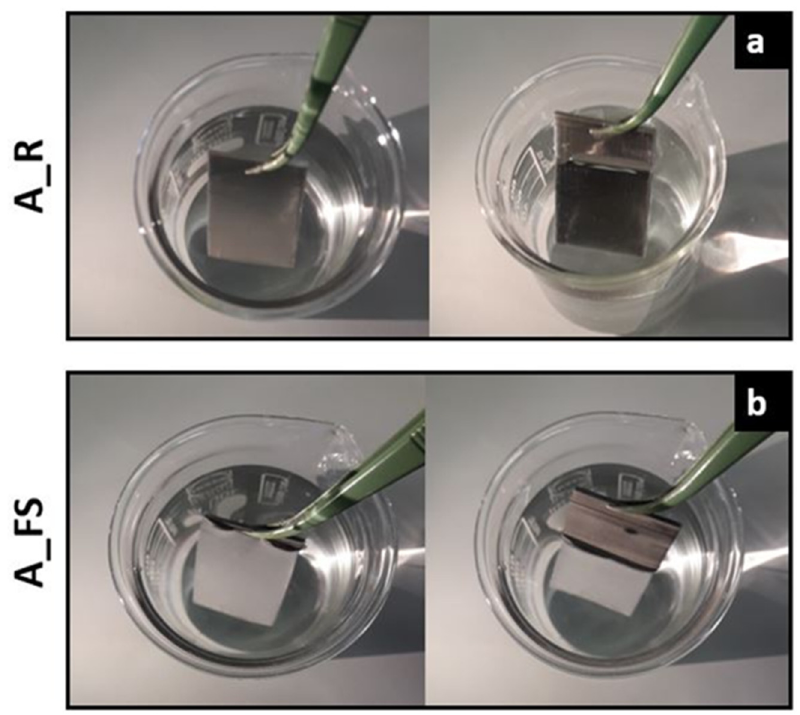
Figure 7. Photographs of as-received Al alloy samples (A_R) ( a ) and superhydrophobic samples (A_FS20) ( b ) immersed in a 3.5 wt.% NaCl aqueous solution.